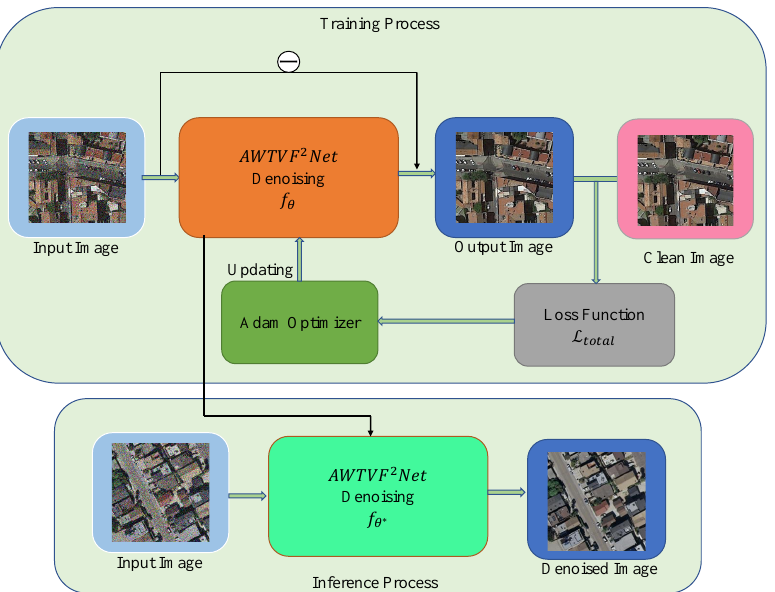
Figure 1. The workflow of our model for remote sensing image denoising. The first subfigure is the training process, which consists of the proposed network, optimizer, and loss functions. The second subfigure is the inference process, which uses the trained networks to restore remote sensing